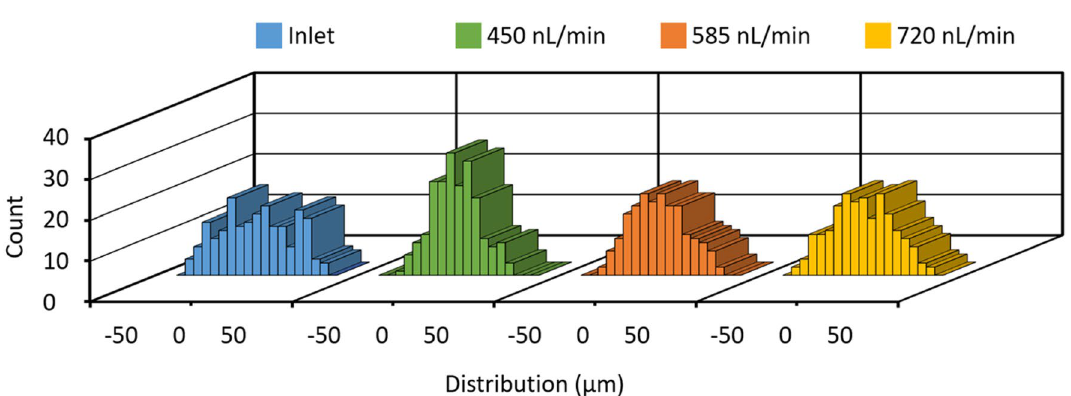
Figure 6. The effect of the flow rate on the focusing of 10-µm polystyrene particles in the microchannel. The injection flow rates are 450, 585 and 720